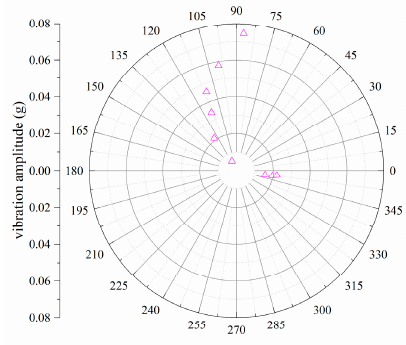
Figure 17. Lateral amplitude diagram of pitch.